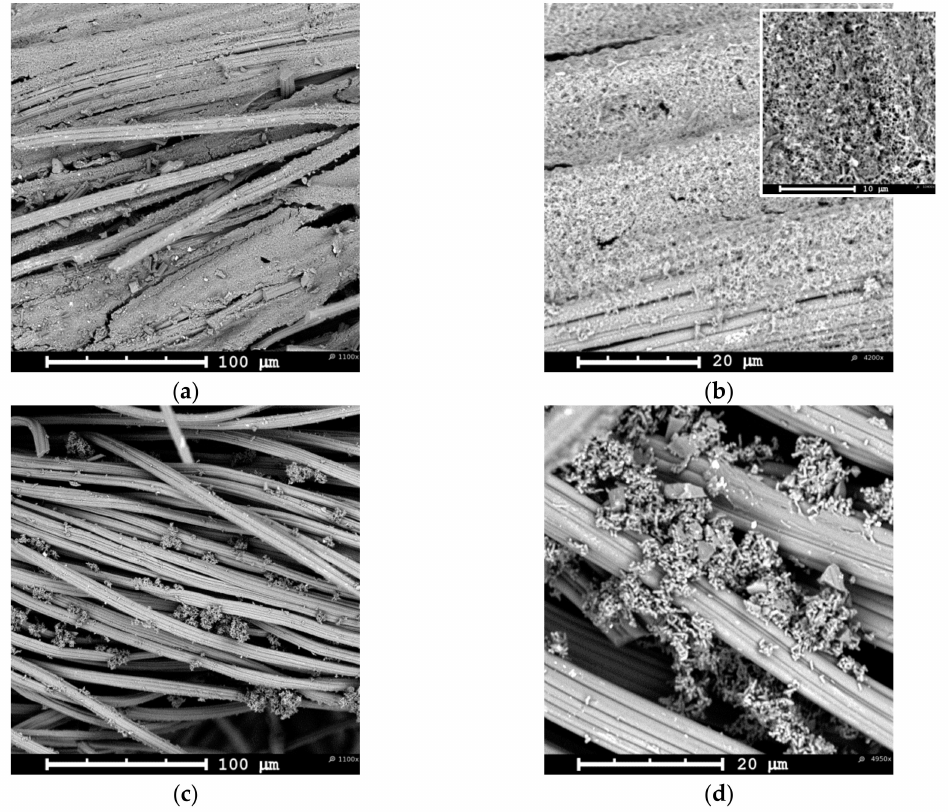
Figure 3. Low- and high-magnification SEM micrographs of PAni-ACC composites synthesized after 120 min of electropolymerization, ( a ), ( b ) electrode side; ( c ), ( d ) electrolyte